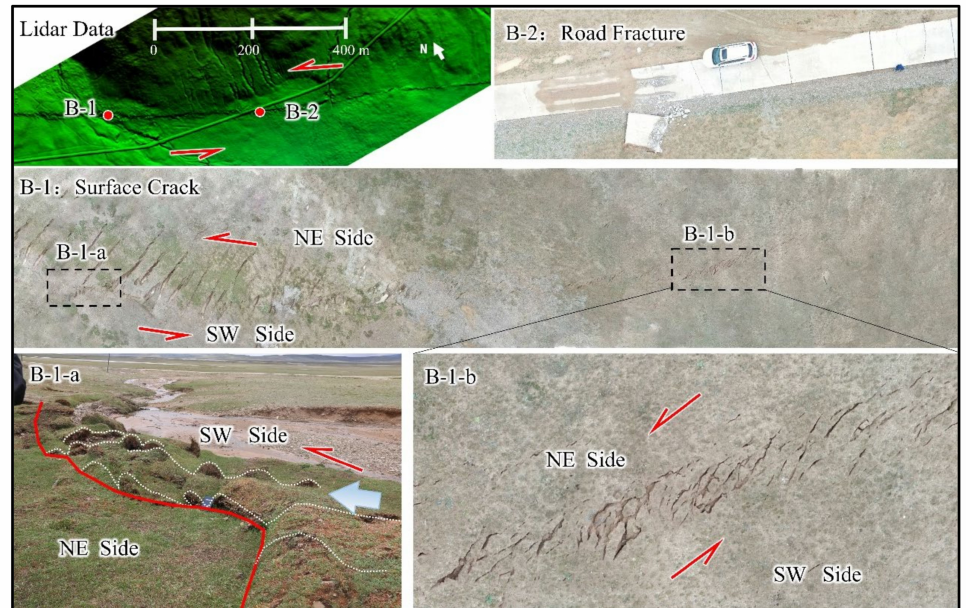
Figure 8. En é chelon cracks and pressure ridges due to sinistral shear along the co-seismic fault of the Maduo earthquake in the field investigation. Red line indicates the fault trace, and the red semi-arrows represent the sinistral shear along the surface rupture. Localities B1 and B2, see Figure